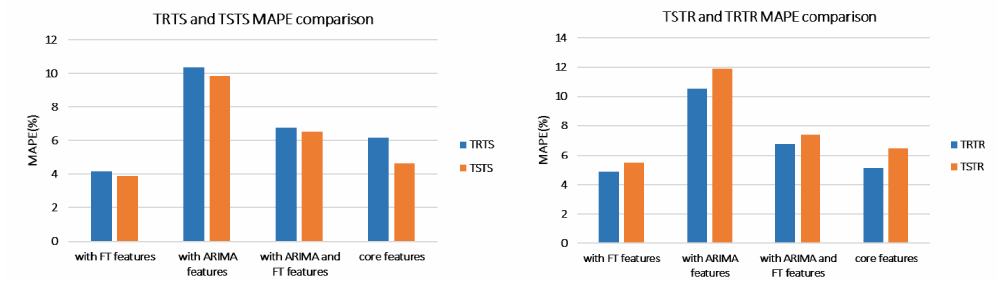
Figure 13. Mean Absolute Percentage Error (MAPE)(%) comparison between TRTS/TSTS and TSTR/TRTR (Building Genome data set).